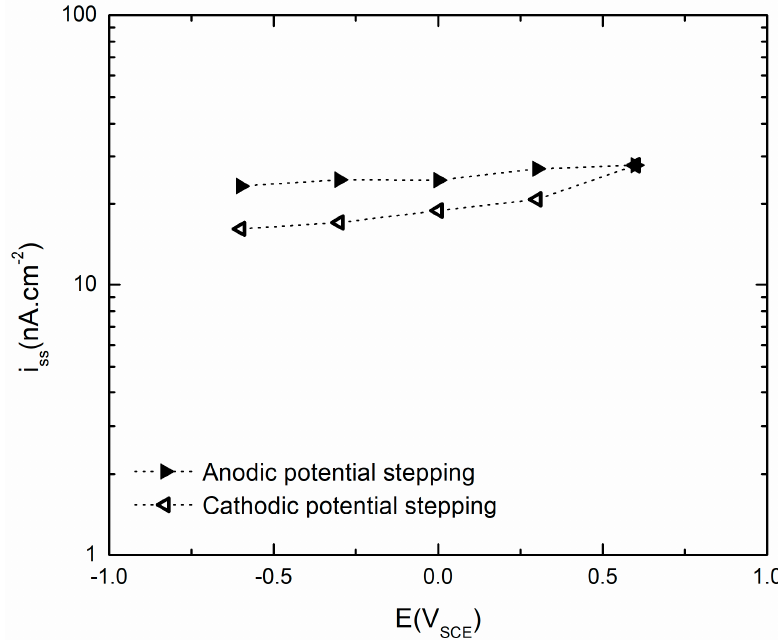
Figure 2. Steady-state current density for both anodic and cathodic potential stepping directions.